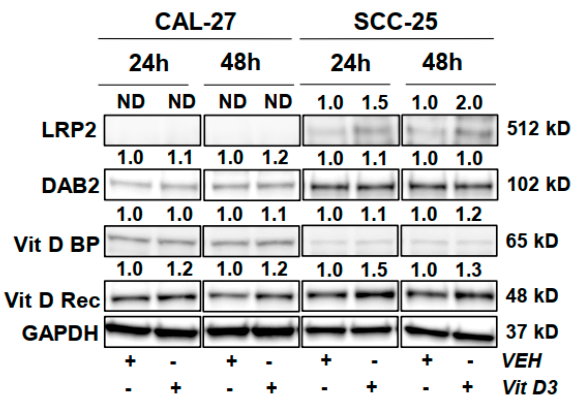
Figure 2. Modulation of vitamin D related proteins. Western blot results for CAL-27 and SCC-25 HNC cell lines following 2 µ M vitamin D treatment. ND indicates no detection. Quantitation was normalized to GAPDH as a loading control and fold-change from vehicle reported.